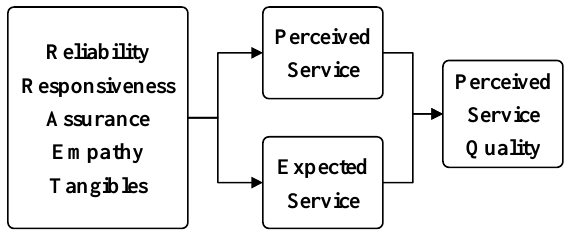
Figure 5: Service quality dimensions in SERVQUAL